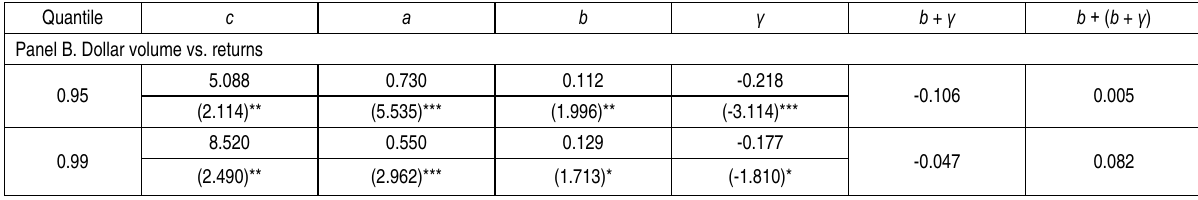
Table 8 (cont.). Quantile regression estimates of volume-signed return correlation for TAIEX in the entirely-eliminated period